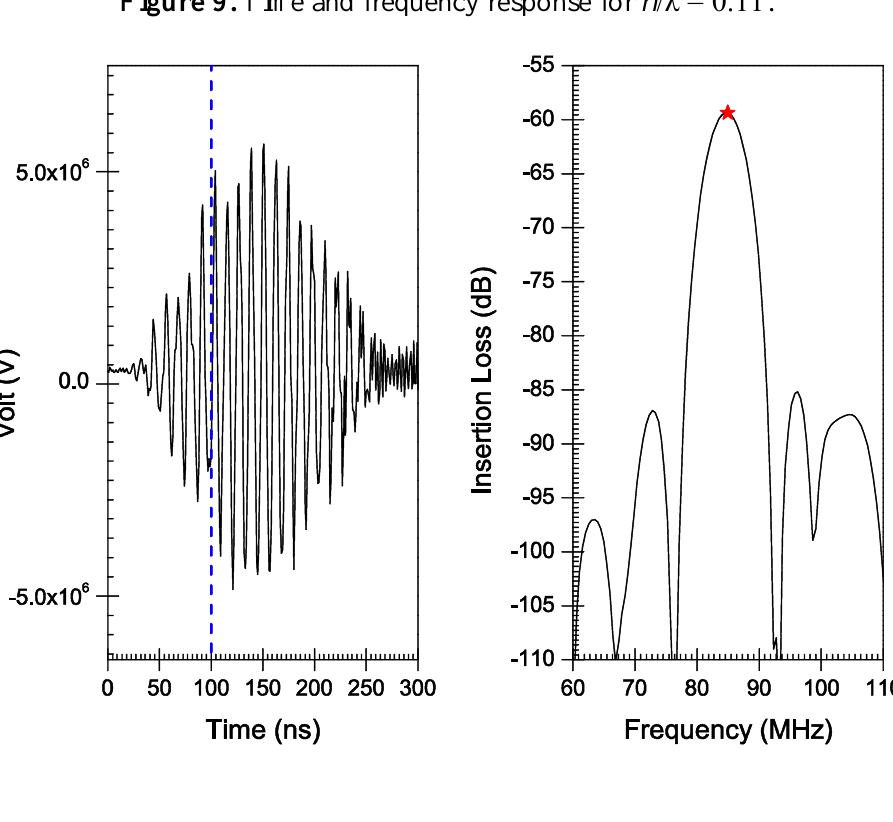
Figure 9. Time and frequency response for h /λ =